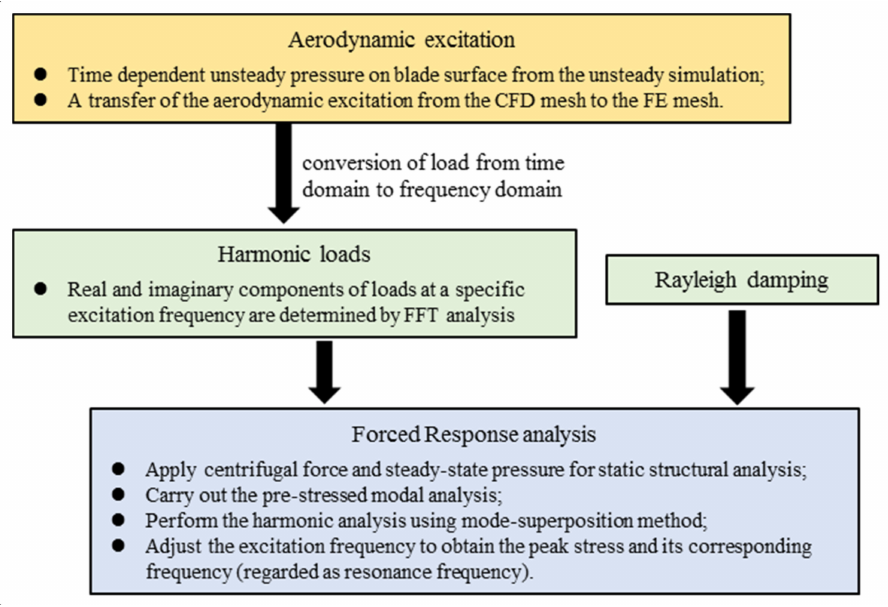
Figure 3. Flow chart of the harmonic forced-response